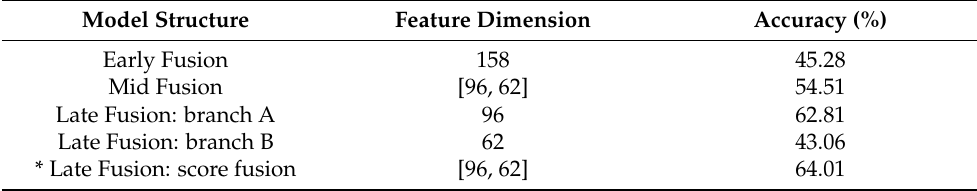
Table 3. Results on JHMDB-1-GT with 3 types of model structures and feature inputs.